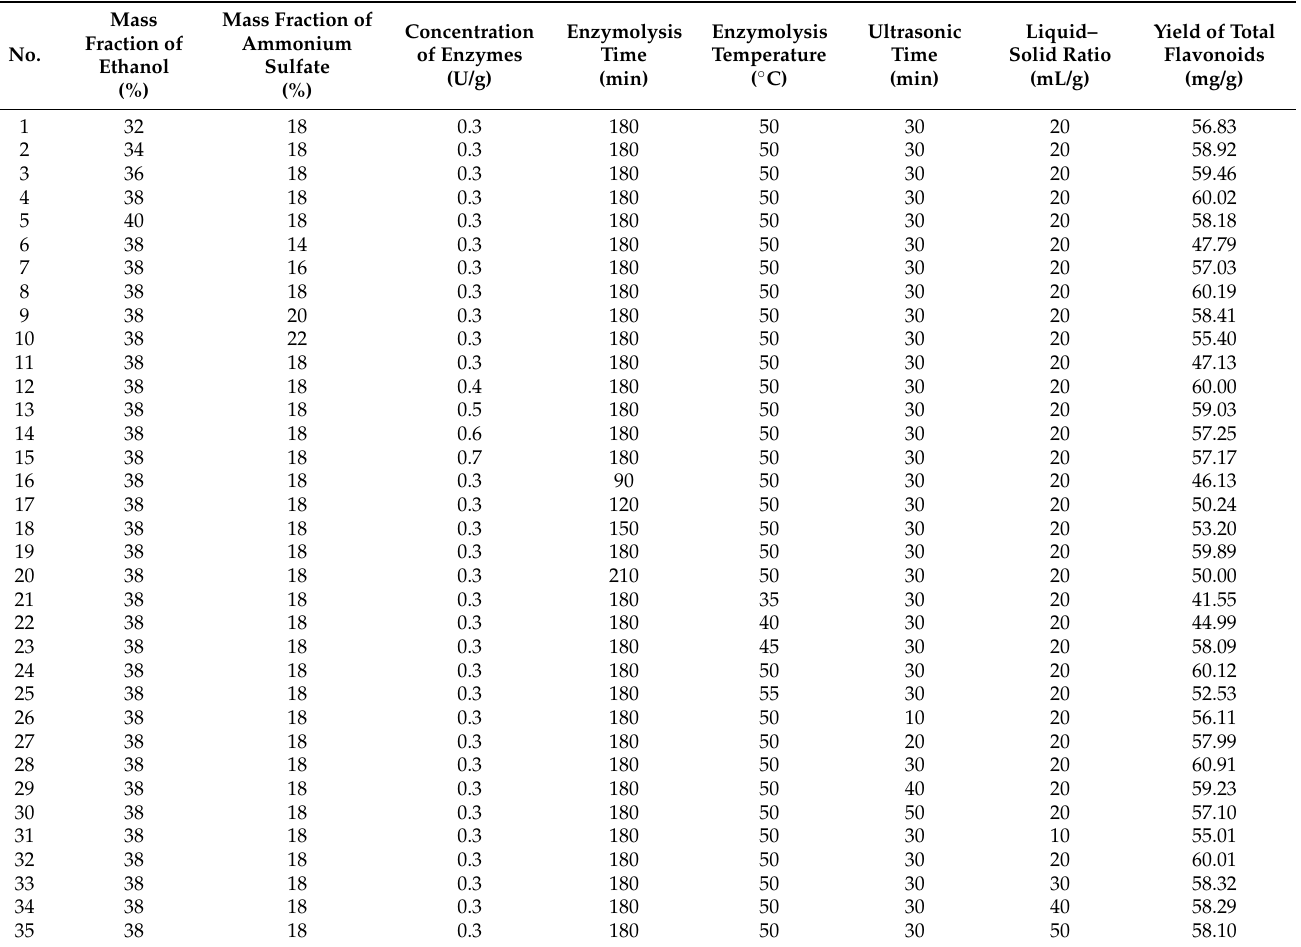
Table 2. Effects of different influencing factors on the yield of total